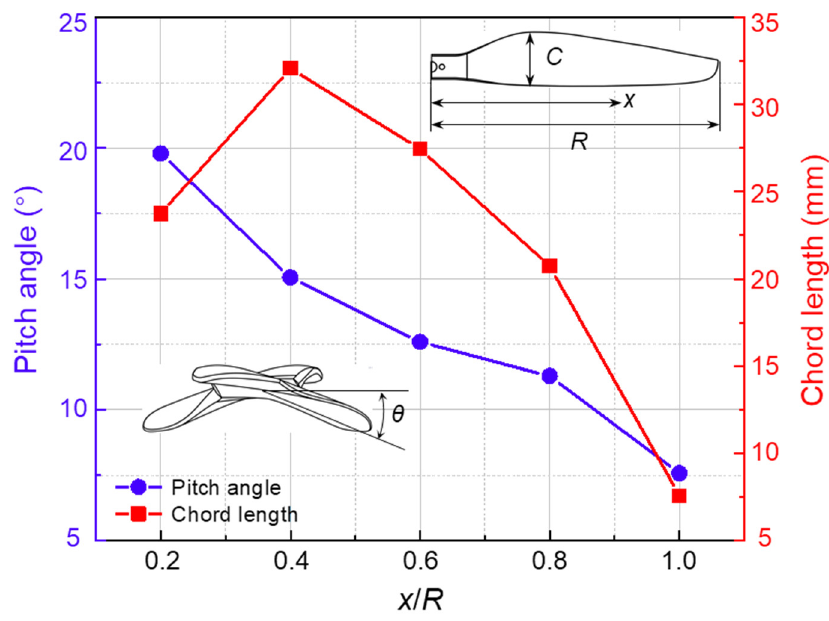
Figure 1. The radial distributions of the chord length and pitch angle of the OR rotor. Inset: Definition of variables C , x , R , and θ .